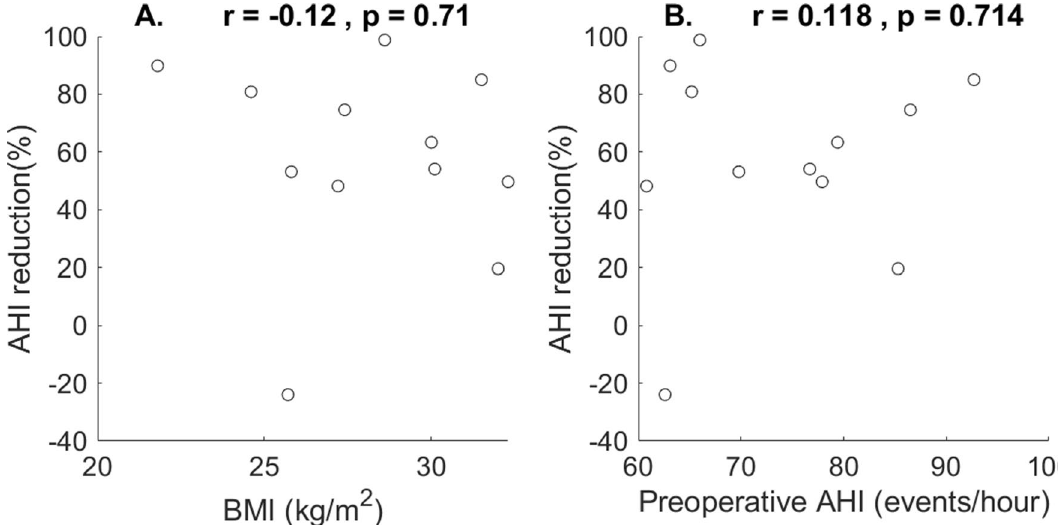
Figure 6. Scatter plot and correlation of preoperative body mass index (BMI) versus apnea–hypopnea-index (AHI) reduction ( A ) and preoperative AHI versus AHI reduction ( B ).